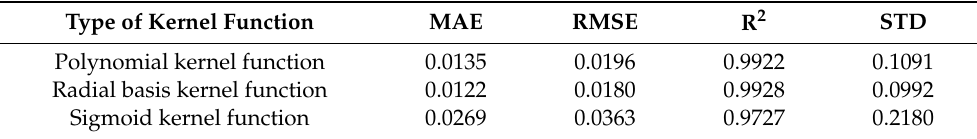
Table 4. Performance of Support Vector Machine (SVM)